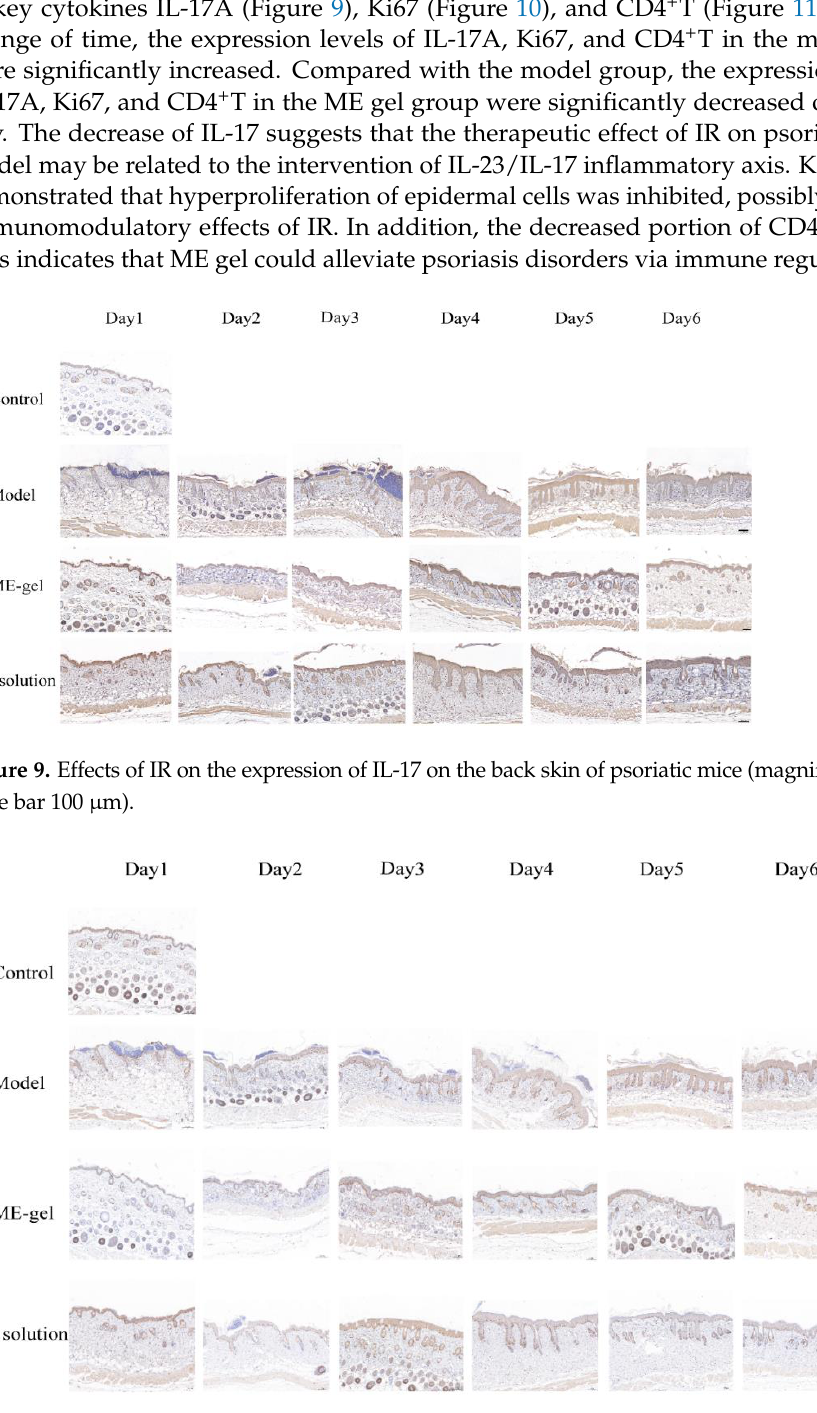
Figure 11. Effects of IR on the expression of CD4 + T on the back skin of psoriatic mice (magnification 100×; scale bar 100 µm). 3. Discussion The self-microemulsion drug delivery system (SMEDDS) is a new type of transder- mal drug delivery system with great potential [32]. Due to the low interfacial tension of ME, it can be formed spontaneously under certain conditions. Due to the fluidity of the interfacial film, the drug can be freely transported between the phases. The transdermal mechanisms of ME include: improving the solubility and loading of drugs, increasing the hydration of the stratum corneum, and destroying the lipid bilayer of the stratum corneum. The basic composition of self-microemulsion includes an oil phase, surfactant, and co-surfactant. When selecting preparation adjuvants, it is necessary to fully consider the compatibility between adjuvants, the compatibility of adjuvants and drugs, and the toxicity and irritation of adjuvants to ensure that the selected self-microemulsion compo- nents are non-toxic, non-irritating, and do not affect drug efficacy [26]. Adjuvants having